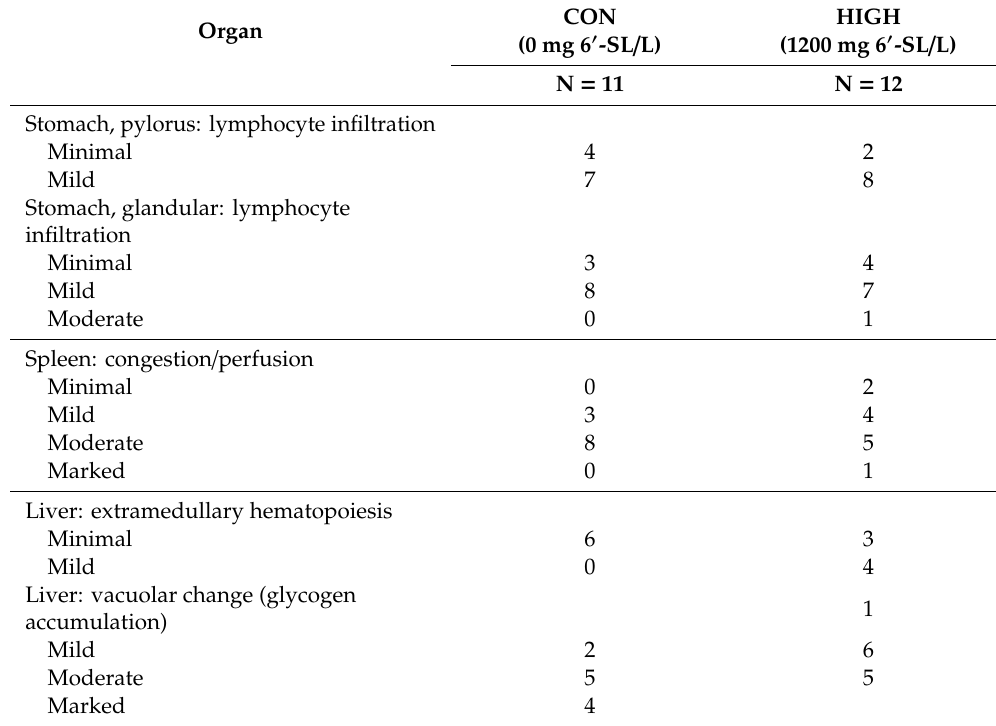
Table 2. The incidence of microscopic histological findings in organs of piglets fed formula alone or formula + 1200 mg / L of 6 (cid:48) -SL sodium salt. Data are shown as the number of animals displaying the characteristic. A five-level severity scoring system was employed in which: 0 = absent; 1 = minimal; 2 = mild; 3 = moderate; 4 = marked; and 5 =